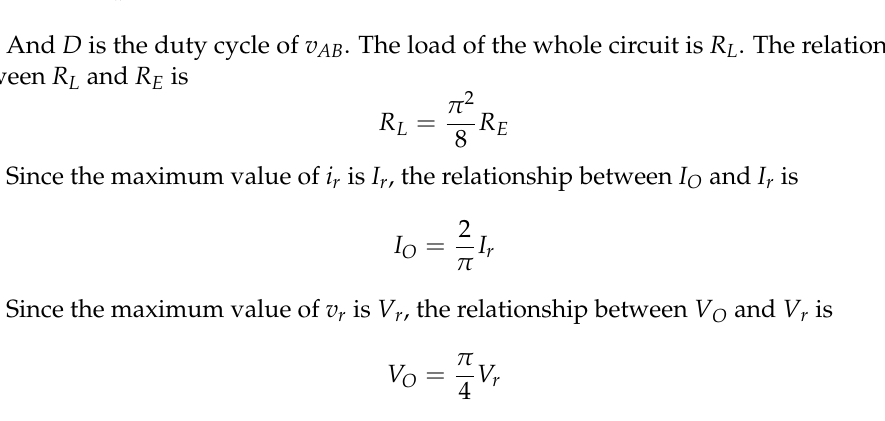
Figure 15. The L x -PS CPT